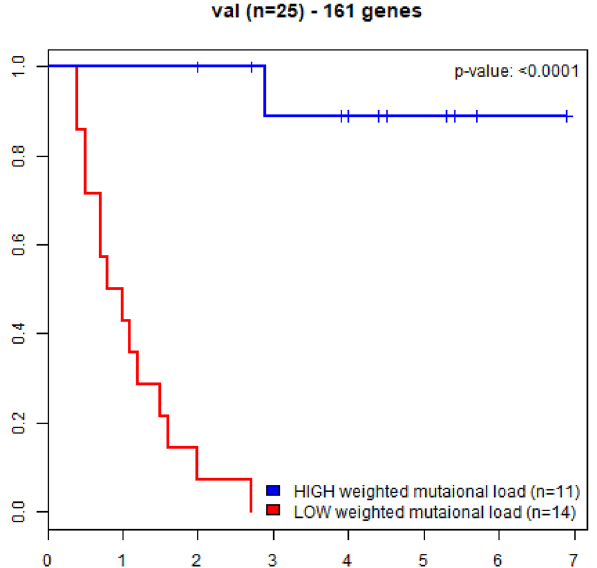
Figure 3. Kaplan–Meier curves for overall survival in advanced melanoma patients treated with immune checkpoint blockade immunotherapy (testing data n = 25); patients with high-weight tumor mutation burden (HW-TMB) had significant longer survival, compared to those with low-weight tumor mutation burden (LW-TMB).